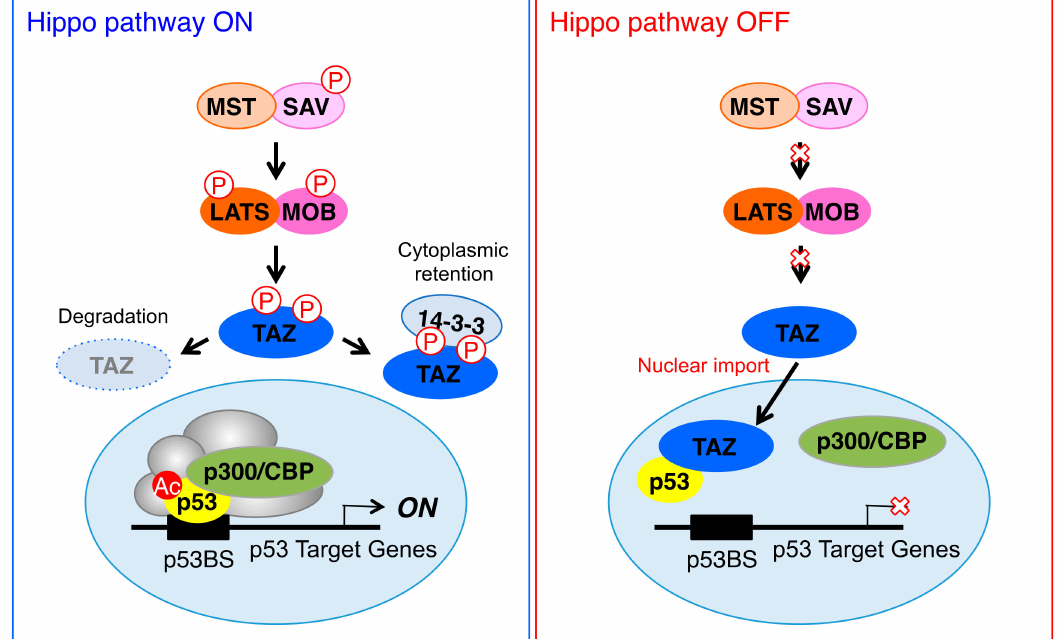
Figure 6. A hypothetical model of p53 transcriptional activity control by TAZ. When the Hippo pathway is activated, TAZ is phosphorylated by its upstream kinases, MST1 / 2 and LATS1 / 2. As a result, TAZ is either degraded by the ubiquitin-proteasome system or bound to 14-3-3 and sequestered in the cytoplasm ( left ). However, mutations in or the altered expression of MST1 / 2 and LATS1 / 2 lead to increased TAZ nuclear localization and activation in cancer cells. Nuclear TAZ suppresses binding between p53 and p300, thereby inhibiting the p300-mediated acetylation of p53. Consequently, TAZ negatively regulates p53 functions by inhibiting p53 transcriptional activity and positively enhances cell proliferation ( right